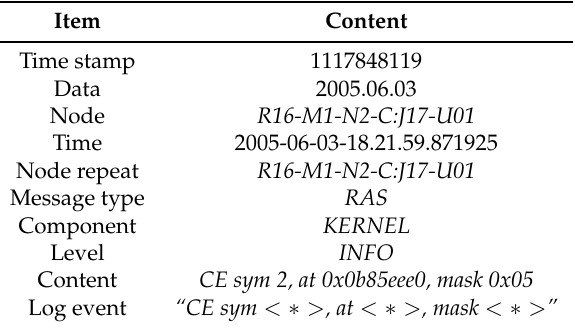
Table 3. Raw log and log